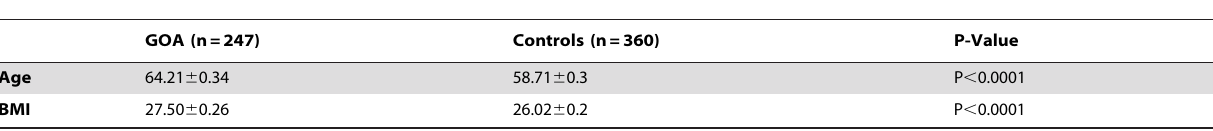
Table 1. Descriptive statistics of the study population.